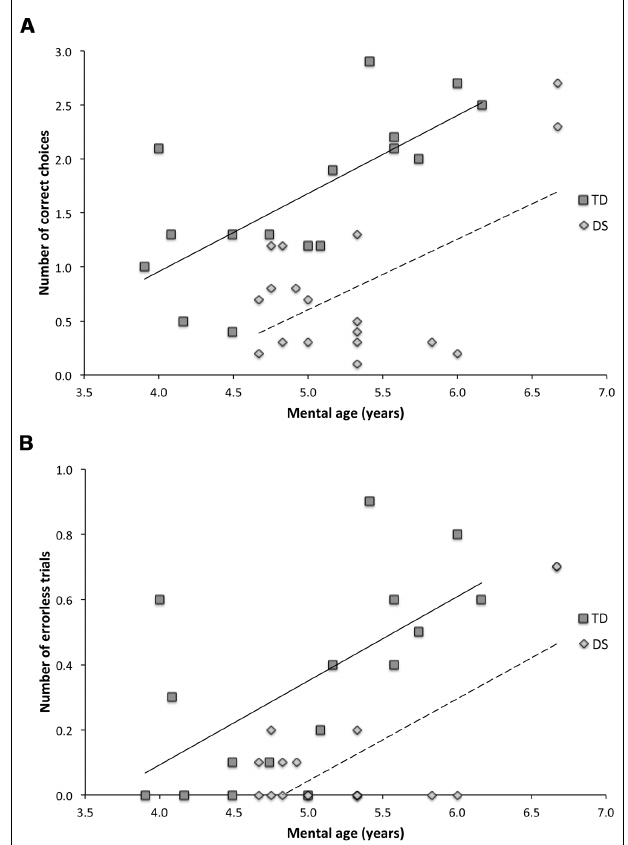
FIGURE 6 | Relationship between mental age (MA) and task performance inTD children and participants with DS. (A) Number of correct choices before erring (CBE) in the AS condition.Typically developing (TD) participants : CBE = 0.719 × MA – 1.920, R 2 = 0.502, F ( 1,14 ) = 14.090, p = 0.002. Participants with Down syndrome (DS): CBE = 0.676 × MA – 2.779, R 2 = 0.344, F ( 1,16 ) = 8.398, p = 0.010.The slopes did not differ [ t ( 30 ) = 0.226, p = 0.8224]. (B) Number of errorless trials (NET) in the AS condition.TD participants: NET = 0.257 × MA – 0.937, R 2 = 0.394, F ( 1,14 ) = 9.098, p = 0.009. Participants with DS: NET = 0.258 × MA – 1.248, R 2 = 0.50184, F ( 1,16 ) = 17.990, p = 0.001.The slopes did not differ [ t ( 30 ) = 0.059, p =